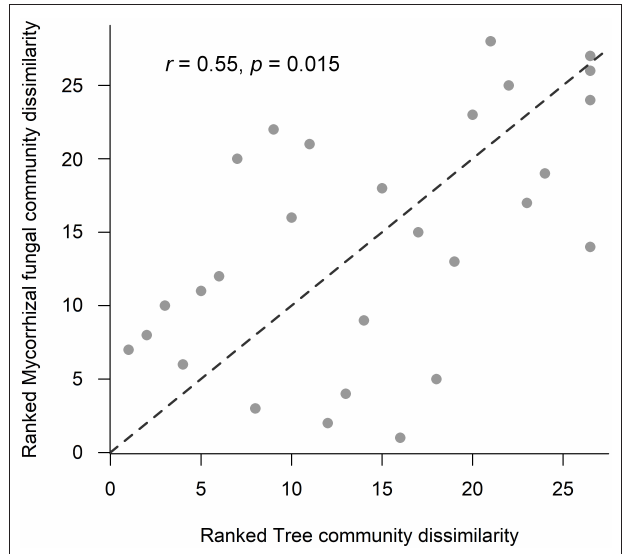
FIGURE 5 | Relationship between ranked tree and mycorrhizal community Bray-Curtis dissimilarities across old-growth and selectively logged lowland dipterocarp rainforest in Sabah, Borneo. Statistics were provided by Mantel test with Spearman’s rank correlation. The r -value represents the Mantel coefficient, and significance level was calculated using 9,999